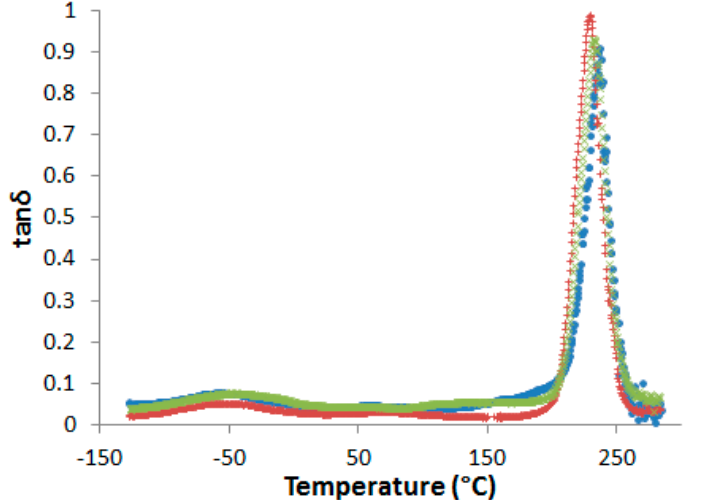
Figure 5. Dynamic mechanical spectra of the neat network and PES-based blends after pre-curing 1 h at 150 ◦ C and post-curing 2 h at 180 ◦ C (flexural mode, heating rate 3 K · min − 1 at 1 Hz). • : neat network; × : nf-PES blend; +: f-PES blend.